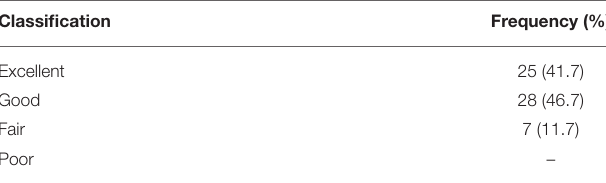
TABLE 3 | Clinical outcome of surgery based on MacNab’s